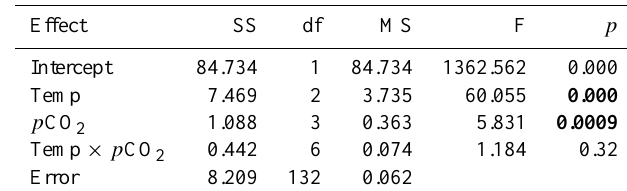
Table 2. Univariate tests of significance indicating the effect of tem- perature and p CO 2 on mortality. Significant results are represented in